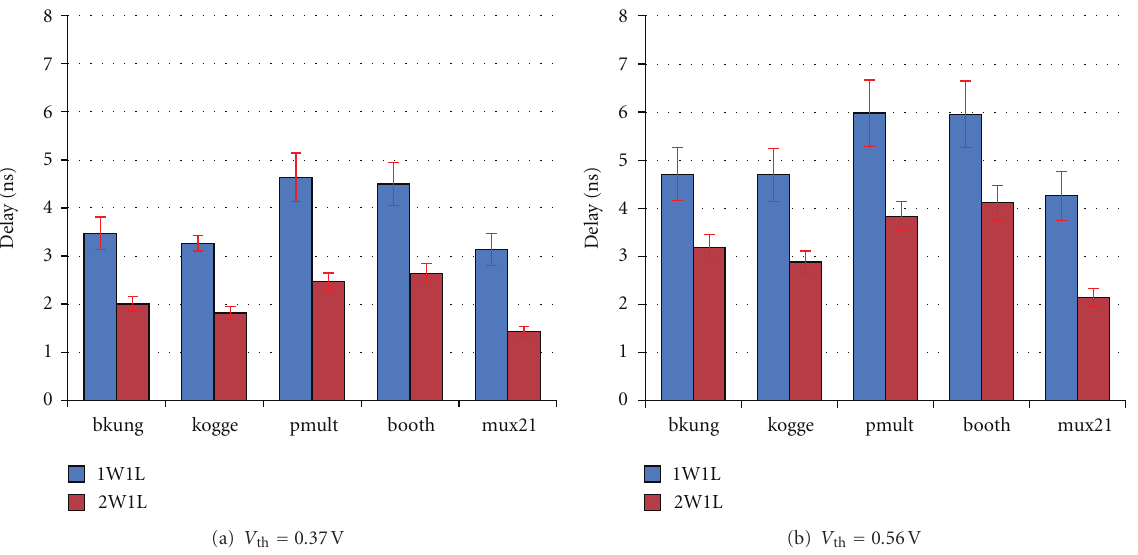
Figure 7: Delay characterization of function units with multi- V th /V dd and variation awareness.